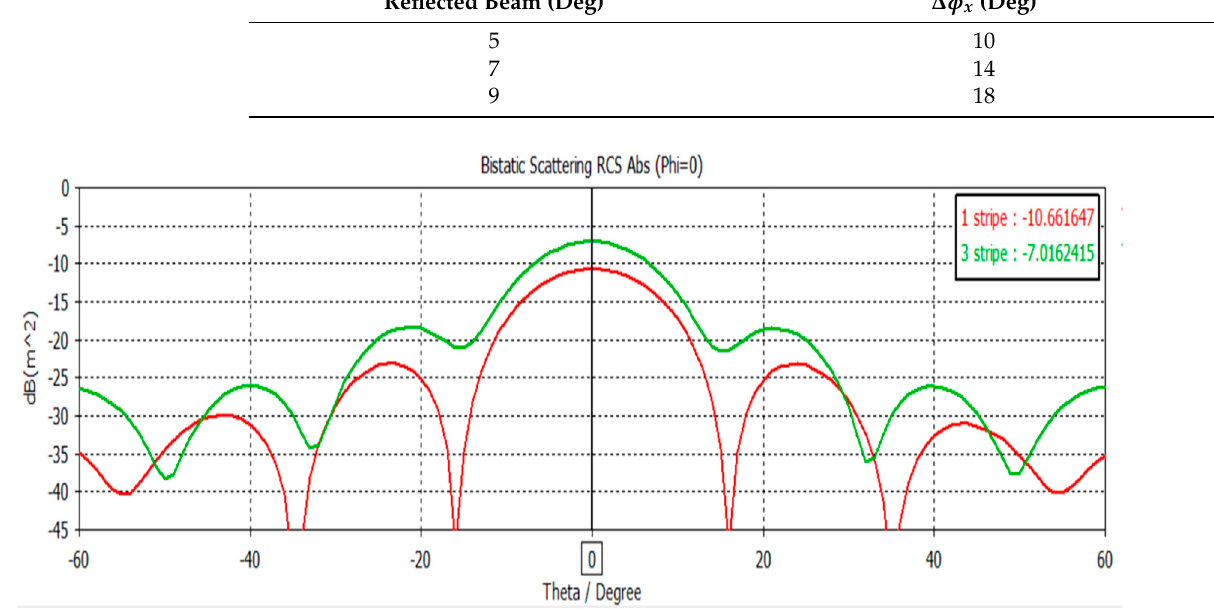
Figure 6. Beam steering far-field radar cross section (RCS) results at 28 GHz with the three-stripe configuration (green) vs. the one-stripe configuration (red). Steering angle simulations results of 0°.